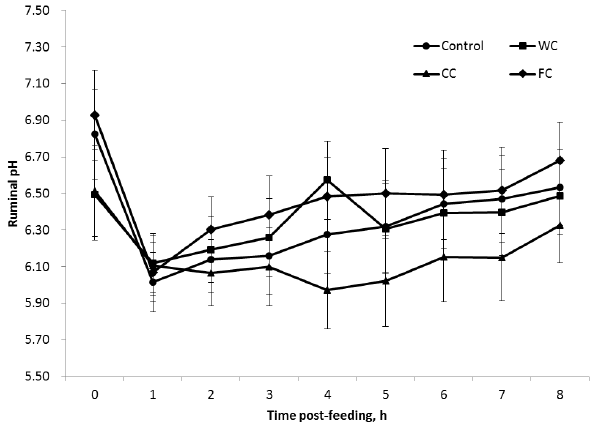
Figure 3. Changes in ruminal ammonia N of Holstein steers fed total mixed ration (TMR) as a basal. Treatments were TMR only (Control, ●), TMR with whole corn grain (WC, ■), TMR with coarsely ground corn grain (CC, ▲) and TMR with finely ground corn grain (FC, ◆ ), respectively.